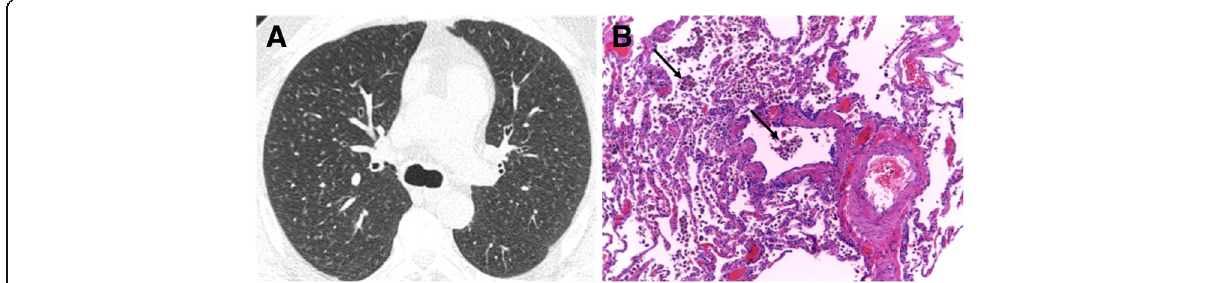
Fig. 15 RB-ILD. a Axial CT image depicts diffuse, ill-defined centrilobular nodules. Due to deteriorating symptoms, the patient underwent lung